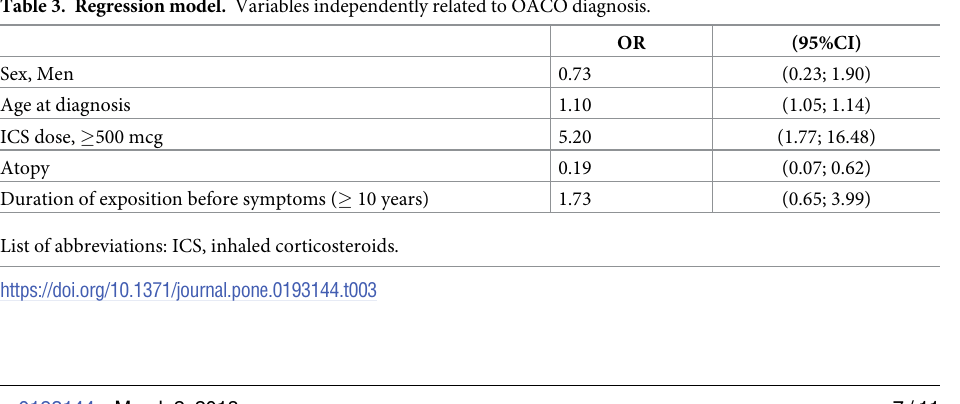
Table 3. Regression model. Variables independently related to OACO diagnosis.